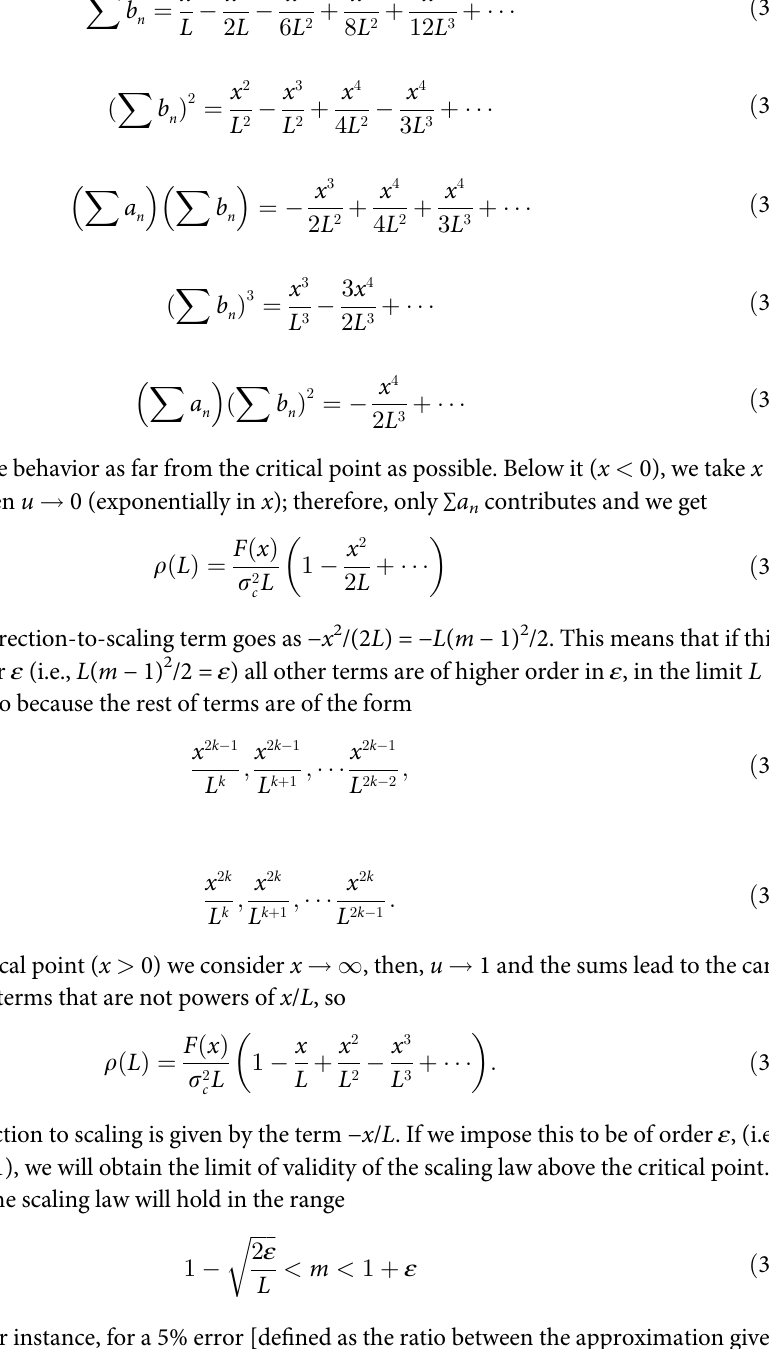
ffiffiffiffiffiffiffiffiffiffiffiffi p 0 : 1 = L < m < 1 : 05